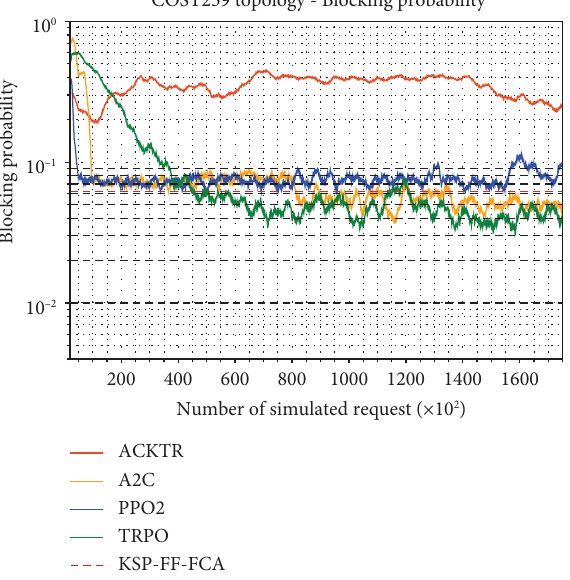
Figure 6: Blocking probability for A2C, PPO2, TRPO, and ACKTR in COST239